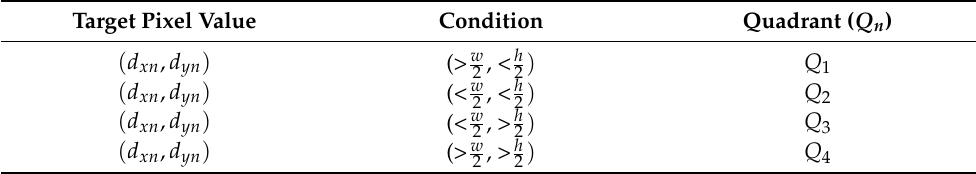
Table 3. Position of target